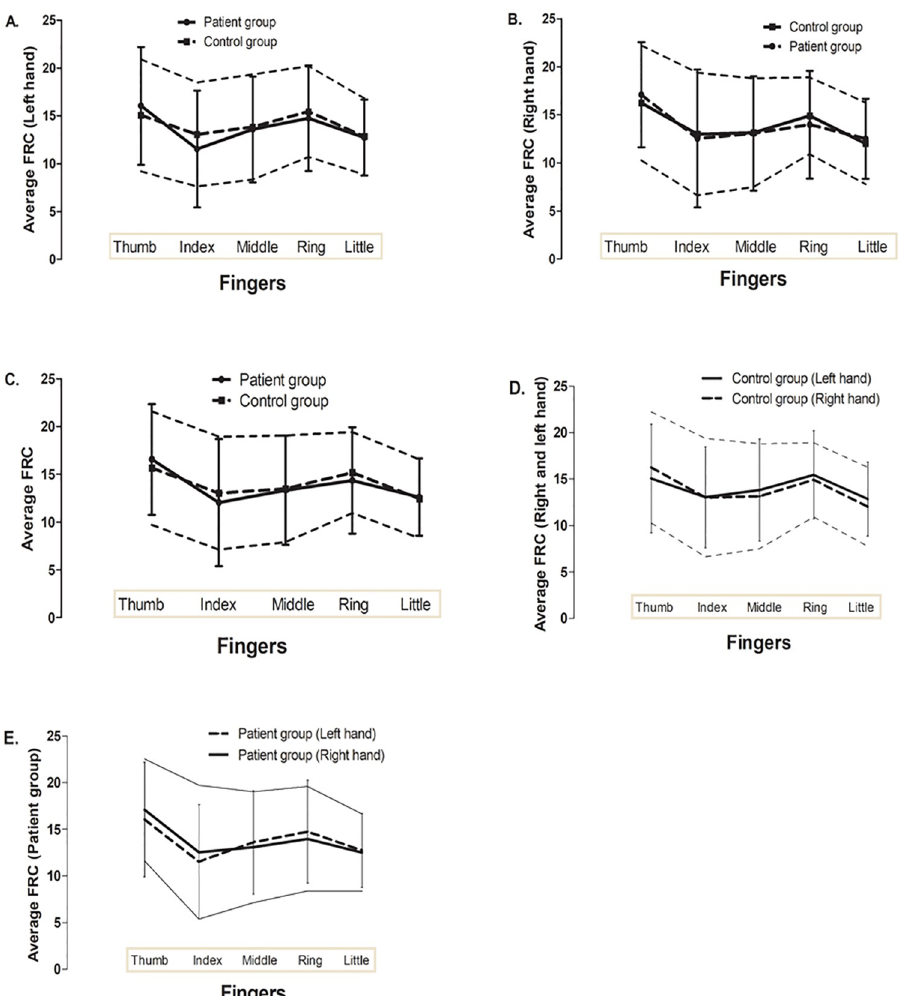
Fig 2. Pattern of average finger ridge count by each finger A. Average FRC (Left hand) B. Average FRC (Right hand) C. Average FRC in patient and control group D. Average FRC in control group (Left and right hand) E. Average FRC in patient group (Left and right hand).